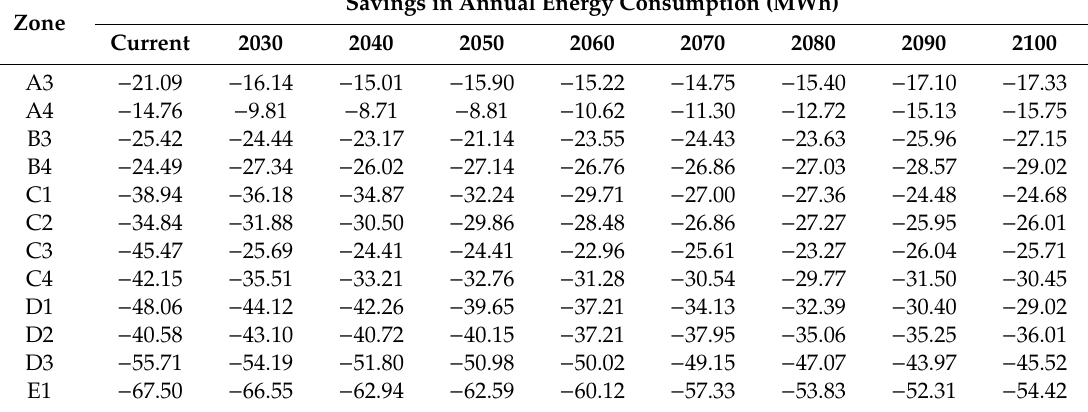
Table 8. Energy savings obtained with ETICS considering an operational pattern based on users working outside the home.